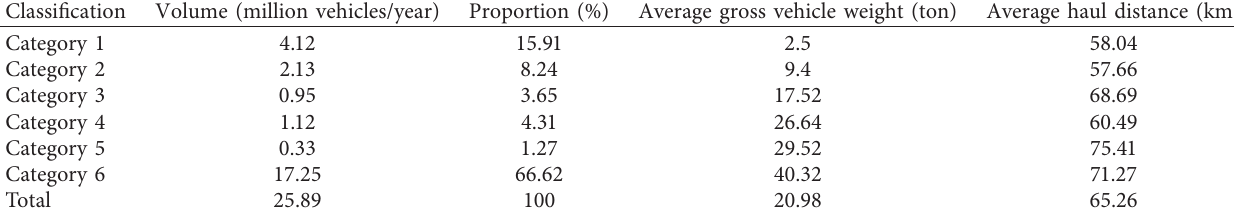
Table 3: Characteristics of various freight vehicles on Xinjiang freeway.